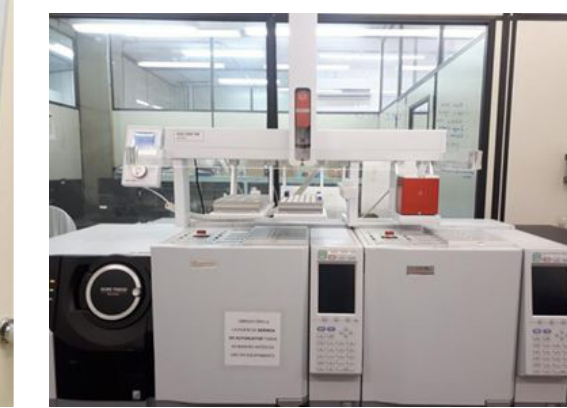
Figure 2. Soxhlet extractor. Figure 3. Chromatographic gas